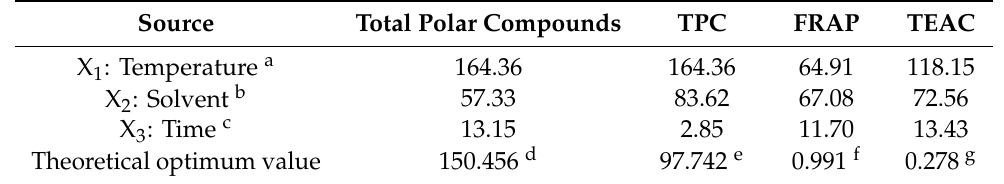
H. sabdari ff a . Response variables: Total Polar Compounds, TPC, FRAP and